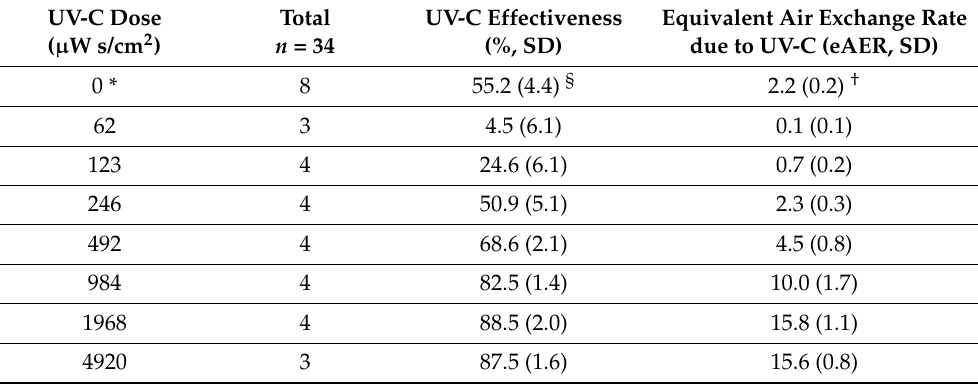
Table 1. UV-C effectiveness (%) against airborne Pa AUST-02 at 60% RH and their equivalent air exchange rates (eAER) per